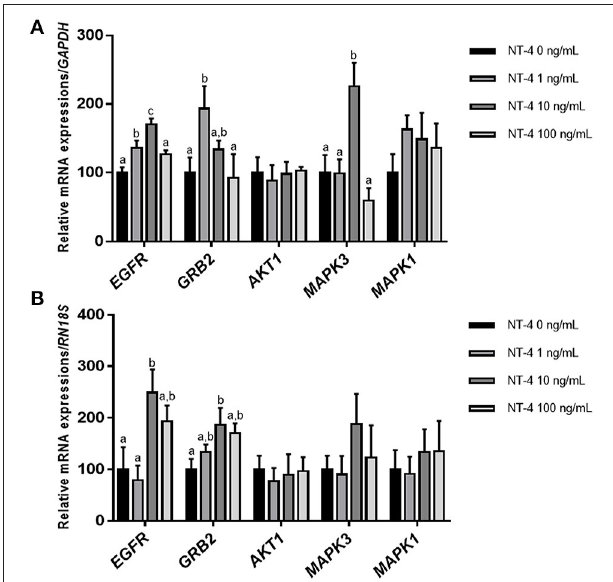
FIGURE 5 | Expression levels of epidermal growth factor receptor (EGFR) signaling pathway-related genes in neurotrophin-4 (NT-4)-treated cumulus cells and oocytes. Mean ± SEM expression of EGFR , GRB2 , AKT1 , MAPK3 ( ERK1 ), and MAPK1 ( ERK2 ) mRNA in (A) cumulus cells and (B) oocytes. This experiment was replicated at least three times. Within each end point, bars with different letters (a, b, and c) are significantly ( p < 0.05)